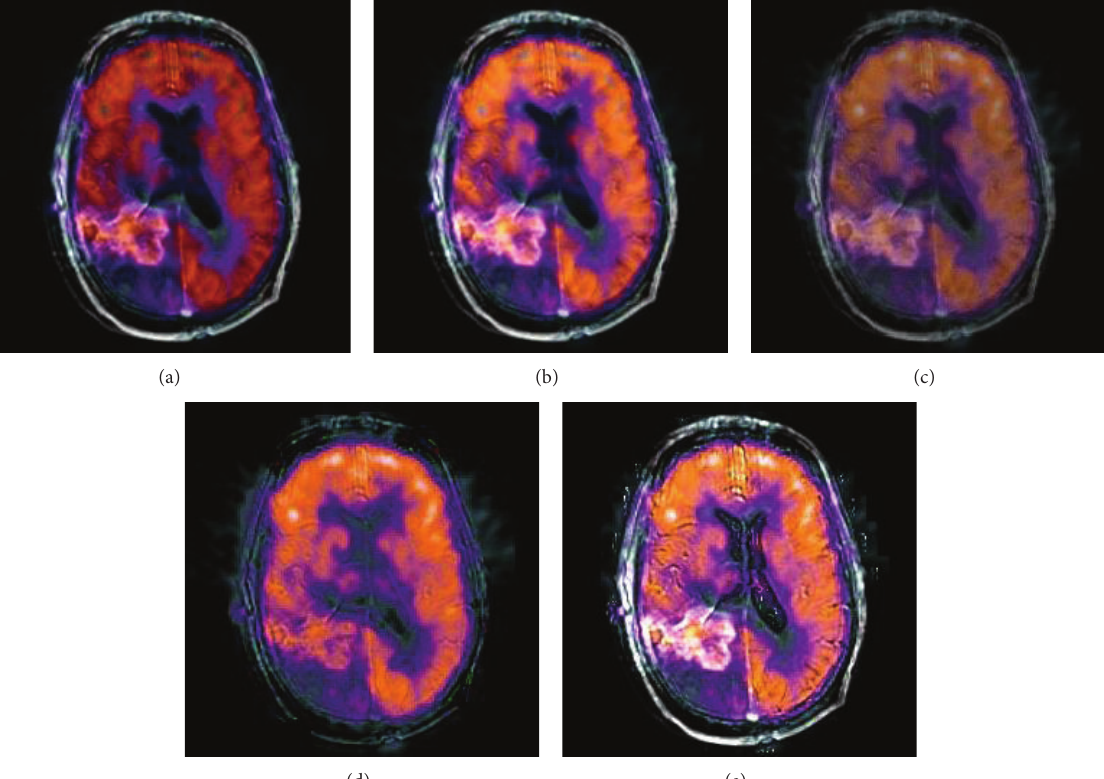
Figure 4: Image fusion results for grade IV astrocytoma images: (a) DWT [12]; (b) GIHS [6]; (c) GFF [33]; (d) IAWP [23]; (e) proposed